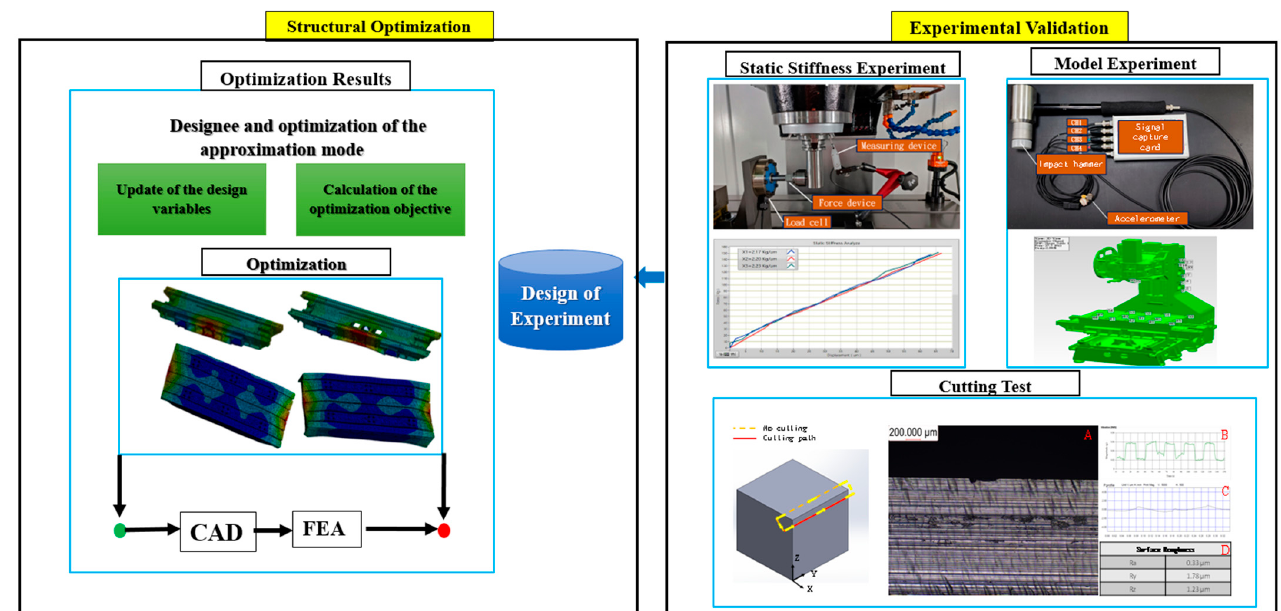
Figure 1. Machine-tool structure design framework based on an integrated structural framework .